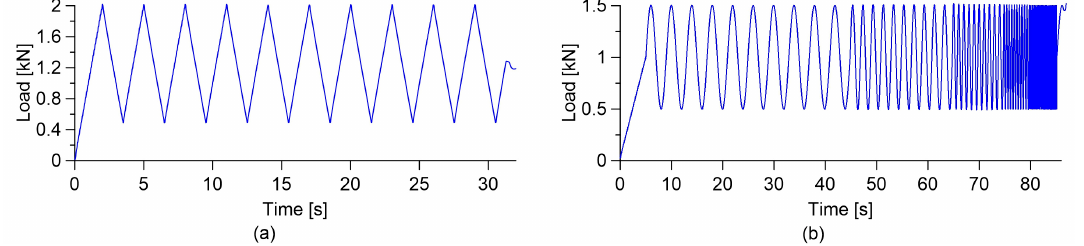
Figure 3. ( a ) Quasi-static uniaxial load; ( b ) Sine-weep dynamic uniaxial load.